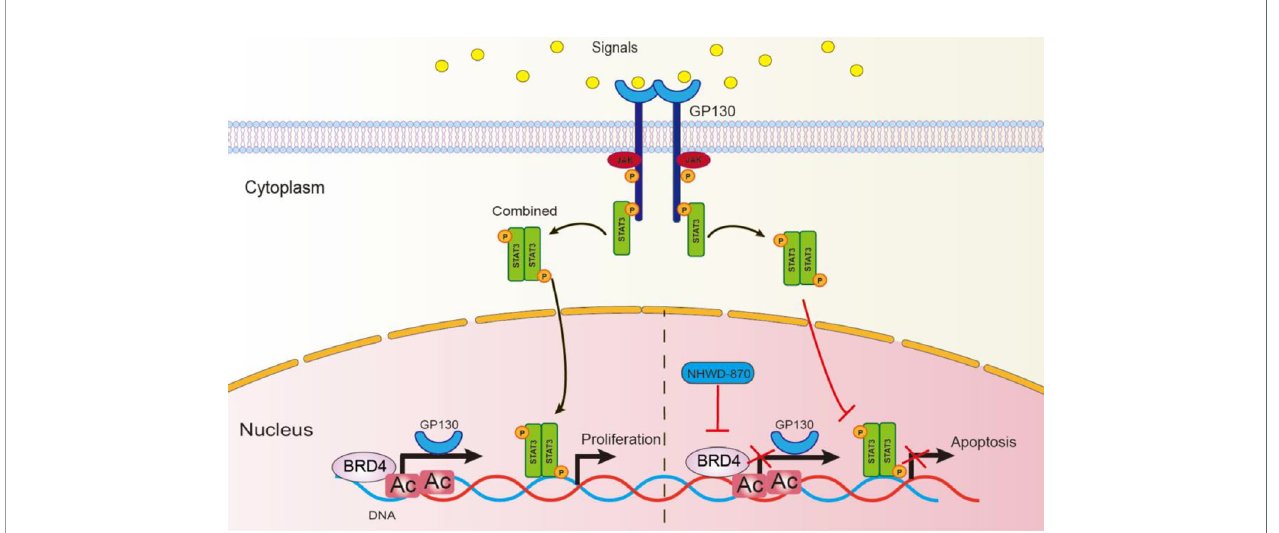
FIGURE 8 | Schematic diagram to describe the action of NHWD-870. STAT3 is phosphorylated by JAKs at tyrosine 705, leading to STAT3 dimerization and nuclear translocation, followed by STAT3-mediated transcription of target genes and cell proliferation. In this process, NHWD-870 disrupted the binding af fi nity of BRD4 to the promoter region of STAT3 upstream receptor GP130, this weakens the upstream signal transduction, blocking STAT3 dimerization and induced cell